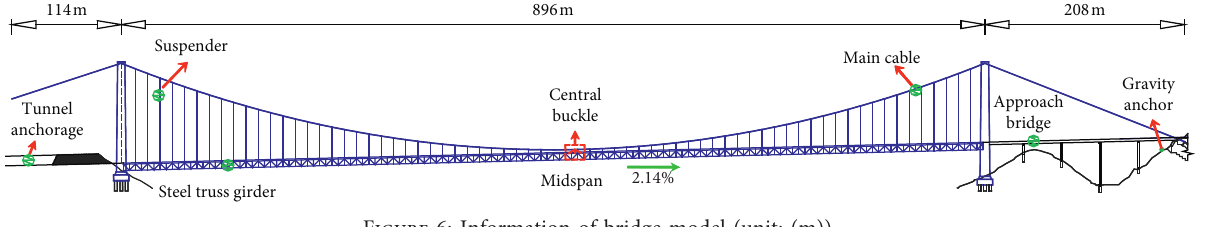
Figure 6: Information of bridge model (unit: (m)).